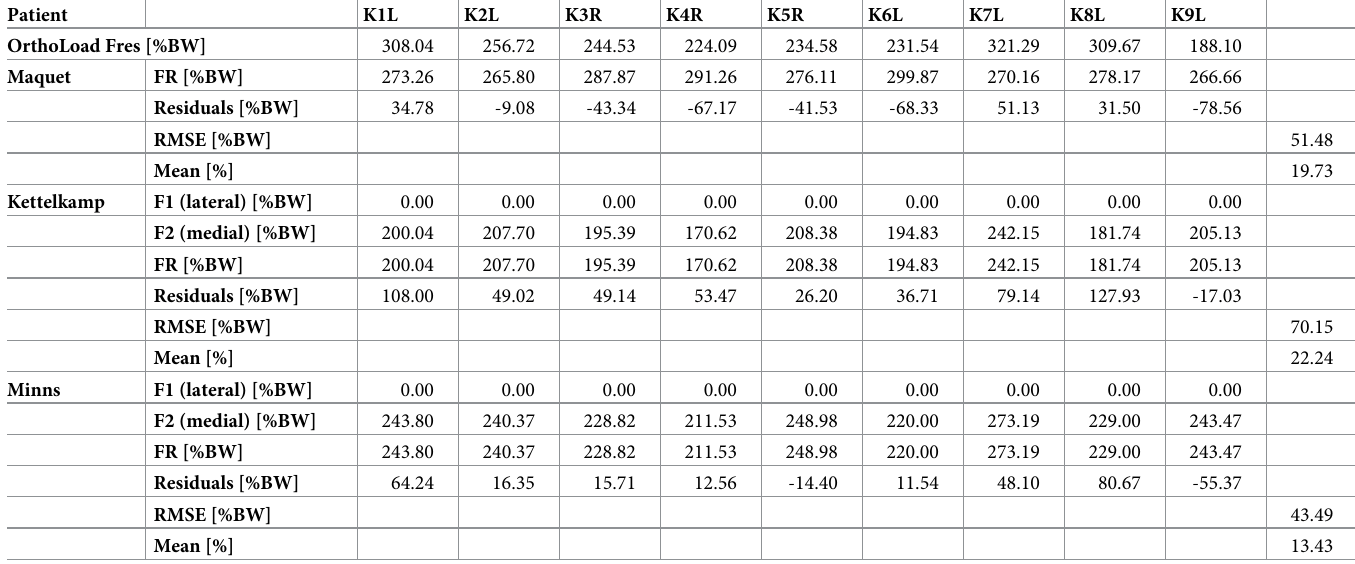
Table 5. Calculated resultant forces from the three models during one-leg stance including medial/lateral load distributions and in vivo measurements from the OrthoLoad database. Forces in %BW, RMSE in %BW and mean differences in % of the average in vivo forces.